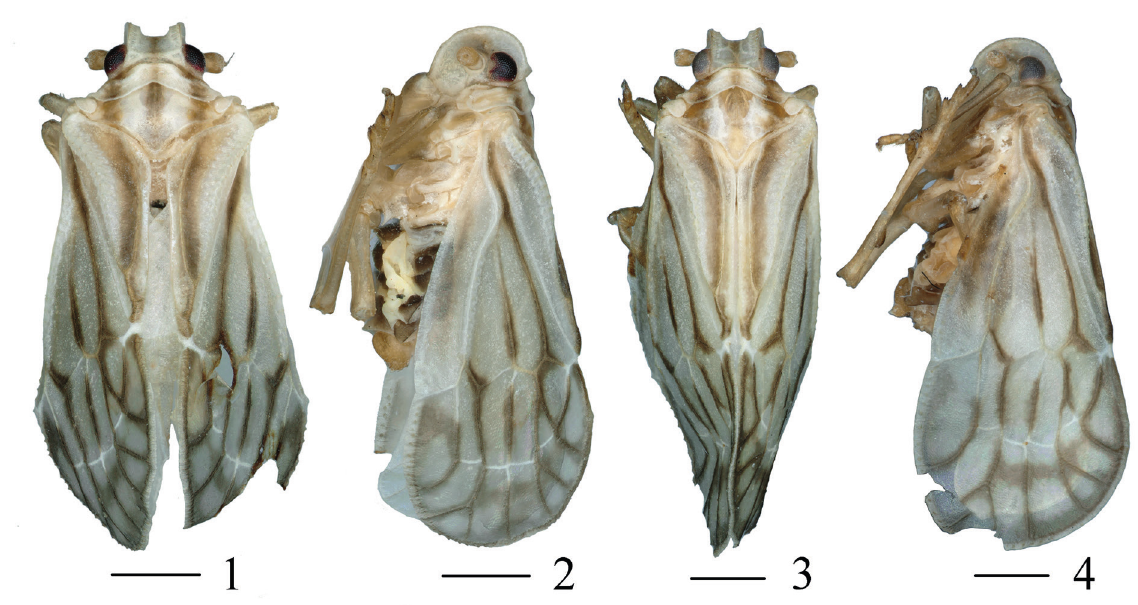
Figs 1–4. Eponisiella dafangensis sp. nov. and Eponisiella shandongensis sp. nov. 1–2 . E. dafangensis sp. nov., ♂ , holotype (IEGU), habitus. 1 . Dorsal view. 2 . Lateral view. 3–4 . E. shandongensis sp. nov., ♂ , holotype (IEGU), habitus. 3 . Dorsal view. 4 . Lateral view. Scale bars = 0.5